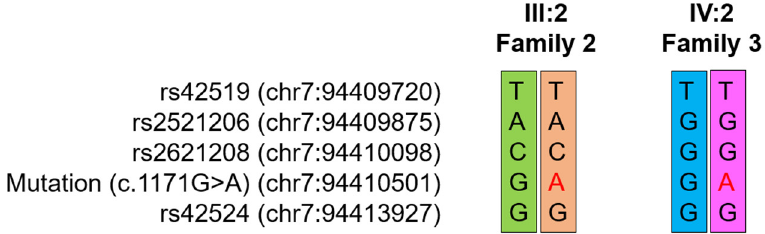
Figure 4. Haplotypes of individuals III:2 of Family 2 and IV:2 of Family 3. Markers are shown on the left with chromosomal locations. Different alleles are shown with different colors. Mutated nucleotides are indicated by a red color.